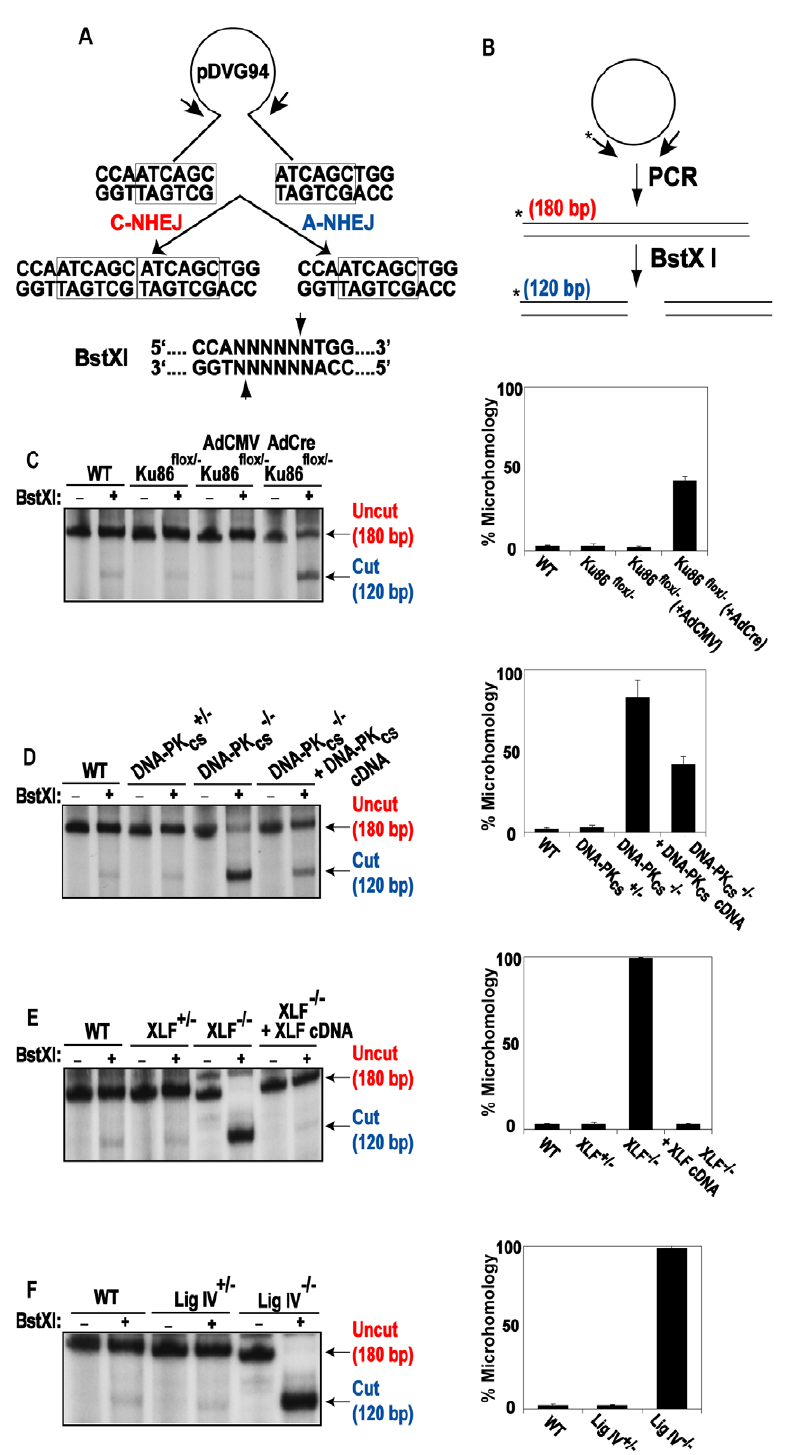
Figure 7. Independent confirmation of microhomology-mediated end joining in C-NHEJ mutant cell lines. (A) Reporter substrate biased for use by microhomology-directed NHEJ (A-NHEJ). The reporter has been designed such that cleavage with Eco47III and EcoRV results in a blunt- ended linear substrate with 6-bp direct repeats (boxes) at both ends. C-NHEJ joining will result in the retention of some of both repeats whereas A- NHEJ should generate a single repeat, which is a substrate for BstXI . This figure is excerpted from Verkaik et al ., 2002, Eur. J. Immunol., 32:701. (B) The experimental scheme for analysis of the plasmids recovered from transfected cells. The plasmids were subjected to PCR using one radiolabeled (asterisk) primer. The PCR products were then subjected to BstXI restriction enzyme digestion. (C–F) Left Panels: Autoradiograms of representative microhomology assays using the indicated cell lines. The size of the primary PCR product (180 bp) and the BstXI cleavage product (120 bp) are indicated. Right Panels: Three independent experiments similar to the ones shown on the left were quantitated with a phosphoimager and averaged.